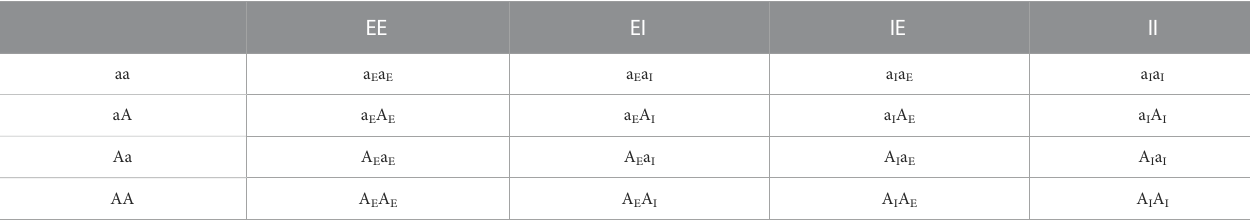
TABLE 1 Ancestry genotype combinations for two-way ancestors.